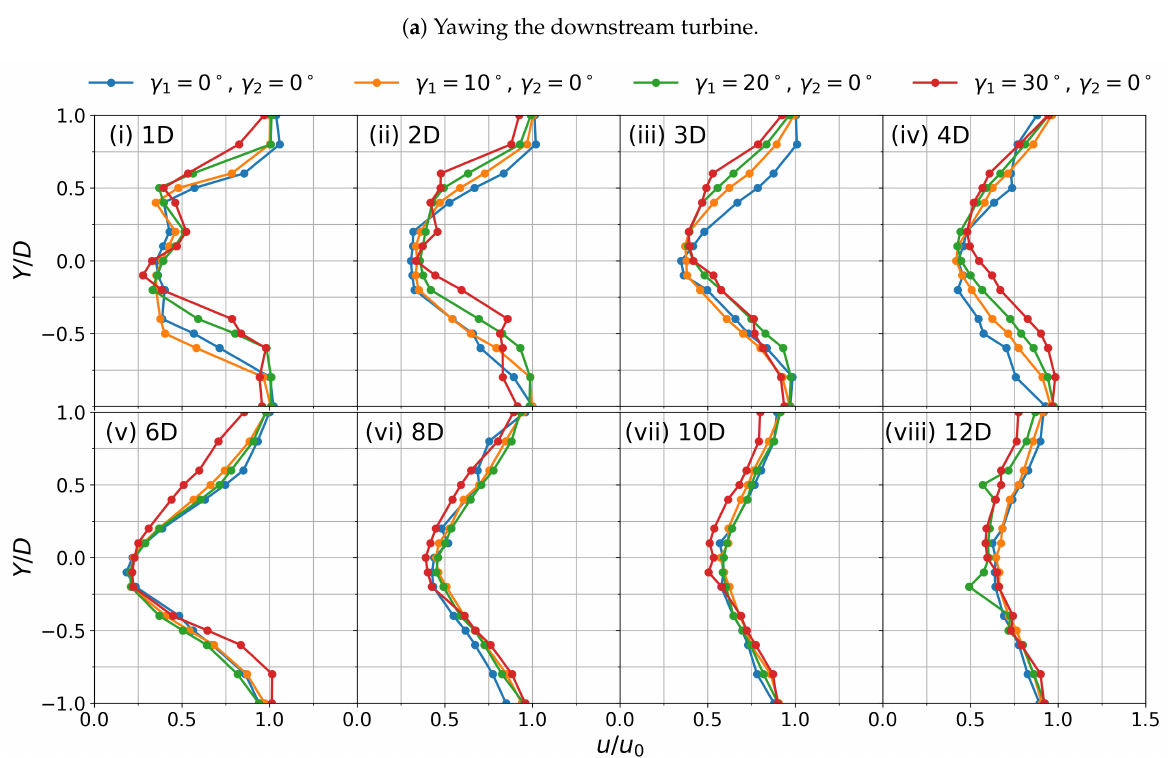
Figure 7. Normalised velocity distribution for the four cases considered in Scenario 2 at eight downstream cross-sections. The separation distance between the profiles and the turbine are (i) 1 D , (ii) 2 D , (iii) 3 D , (iv) 4 D , (v) 6 D , (vi) 8 D , (vii) 10 D , and (viii) 12 D ,